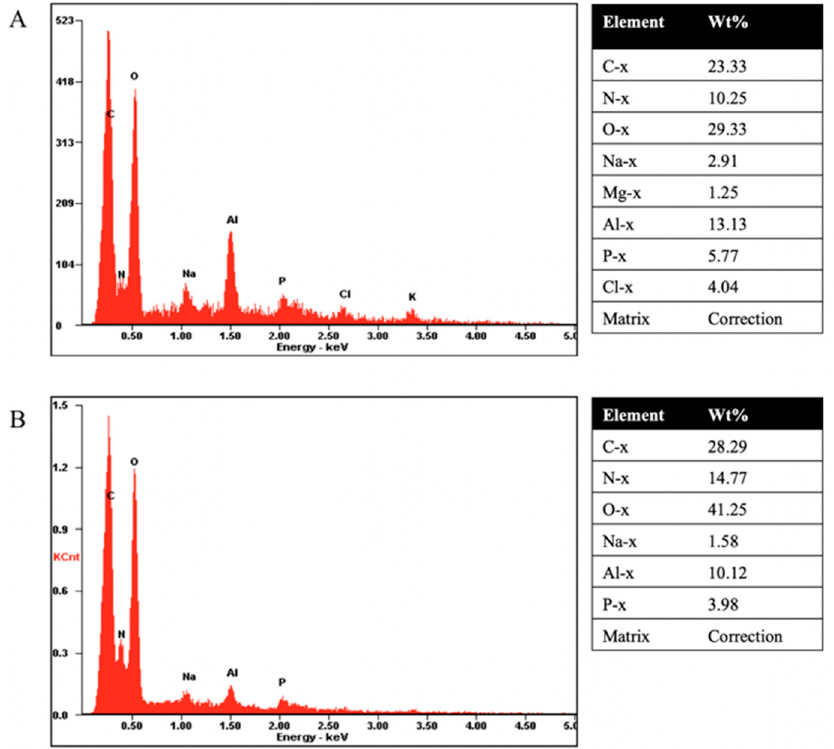
Figure 4. Chemical–elemental analysis obtained by SEM. ( A ) X-ray analysis of each element present in the wet bDLE; the respective table shows the containing weight percentage for each element. ( B ) X-ray analysis of each element present in the dry bDLE; the respective table shows the containing weight percentage for each element.